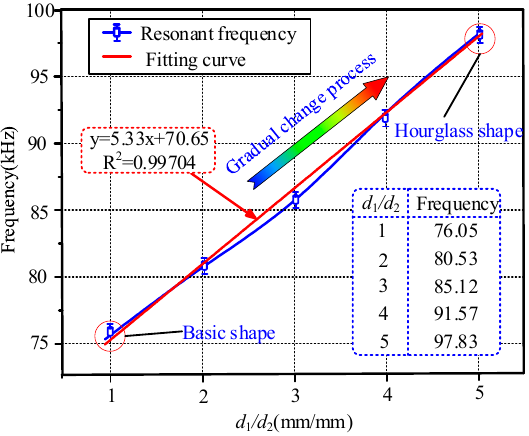
Figure 9. Plot of the no-load resonant frequency versus the ratio ( d 1 / d 2 ).